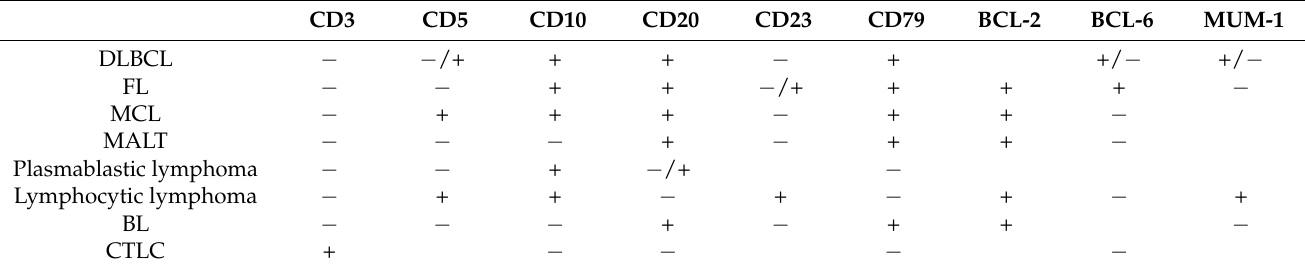
Table 1. Immunohistochemical panel of ENHL